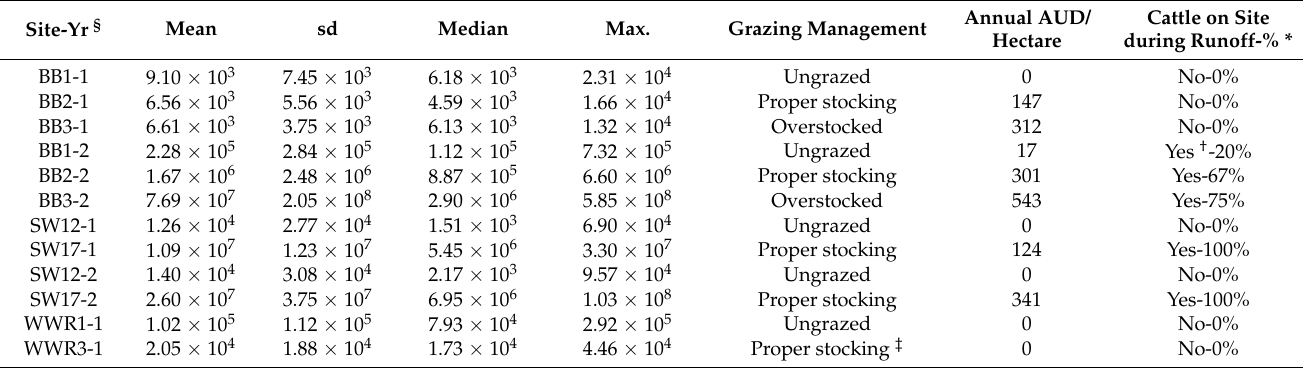
Table 2. Comparison of annual BoBac concentrations (copies/L) with grazing management, stocking rate (AUD/hectare), and cattle presence during runoff